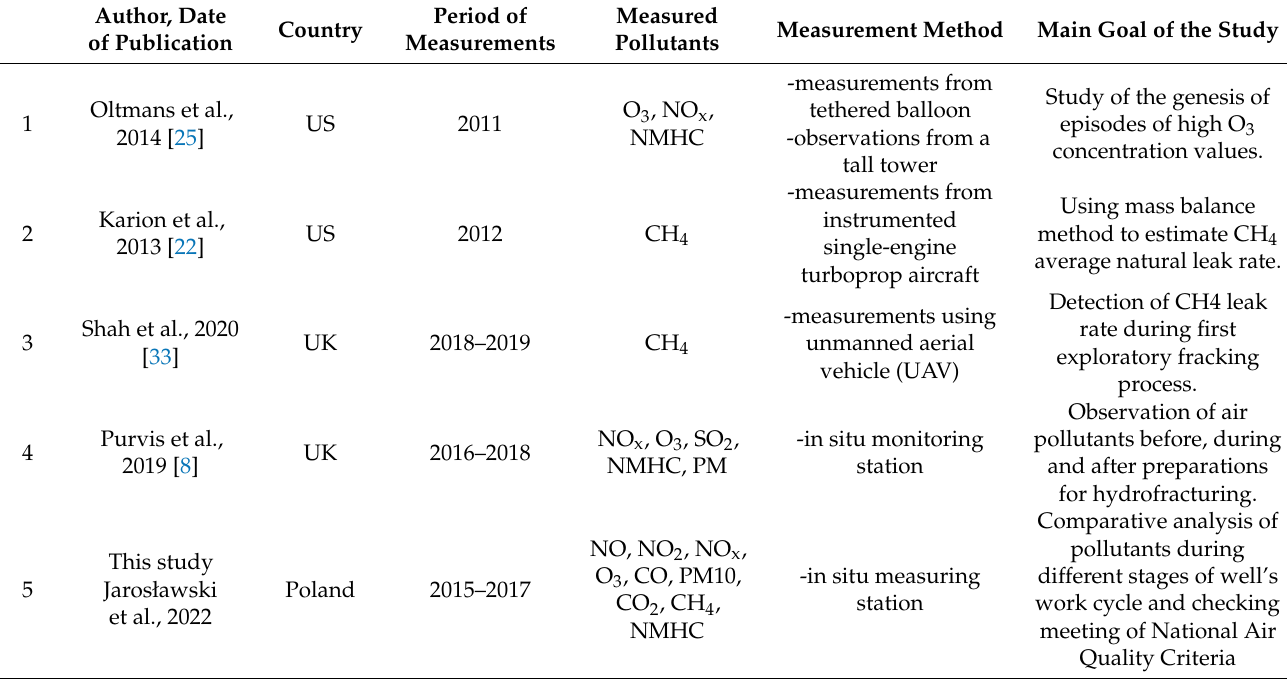
Table 1. List of shale gas research